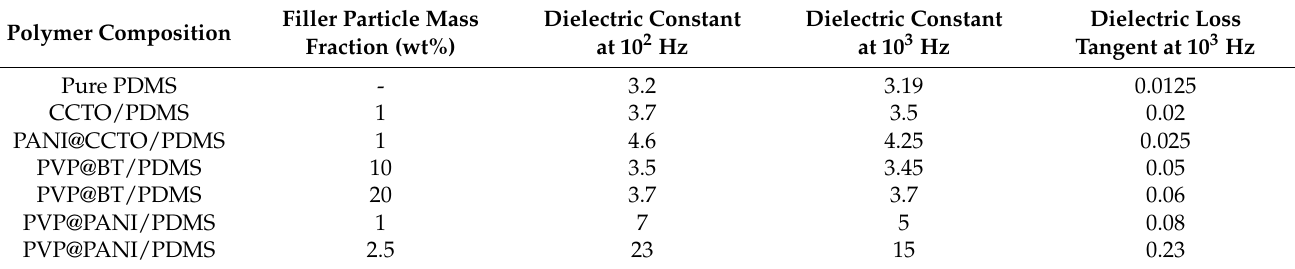
Figure 5. Dielectric constant and electrical conductivity of PVP@PANI/PDMS composites and PANI/PDMS composites with different PVP@PANI contents. ( a ) Dielectric constant of random composite. ( b ) Dielectric constant of assembled composite. ( c ) Conductivity of random composite. ( d ) Conductivity of assembled composite. Table 1. Reported properties of similar dielectric composites and our PVP@PANI/PDMS (where PDMS is polydimethylsiloxane) prepared by electric field